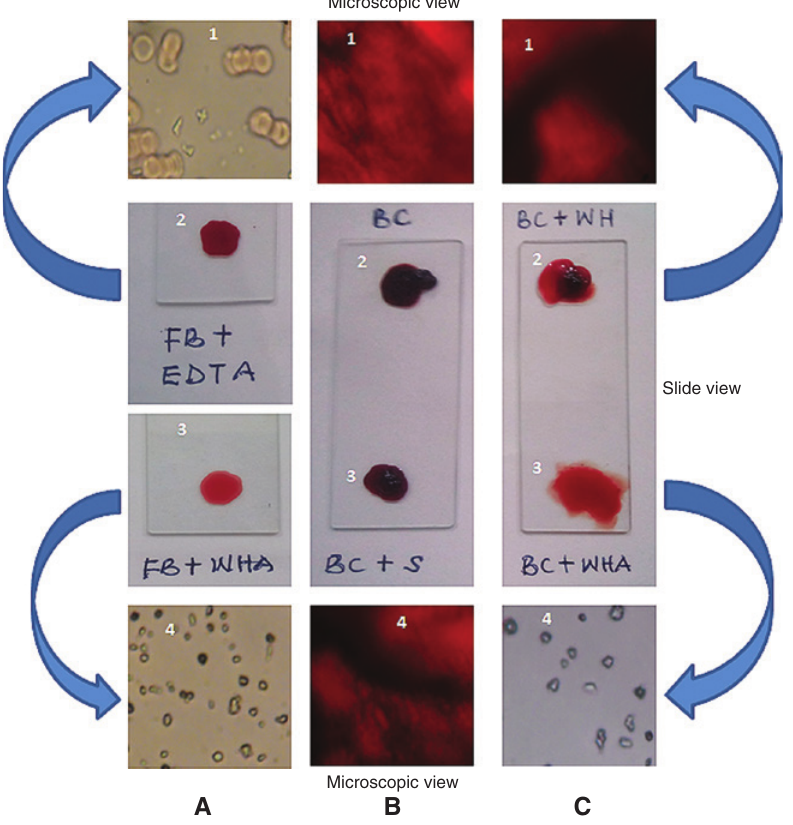
Figure 6: Anticoagulant (A) and thrombolytic activities (B and C) of biosynthesized AgNPs. FB, fresh blood; EDTA, anticoagulant; WHA, nest extract AgNPs; BC, blood clot; S, AgNO solution; WH, nest extract only. 3